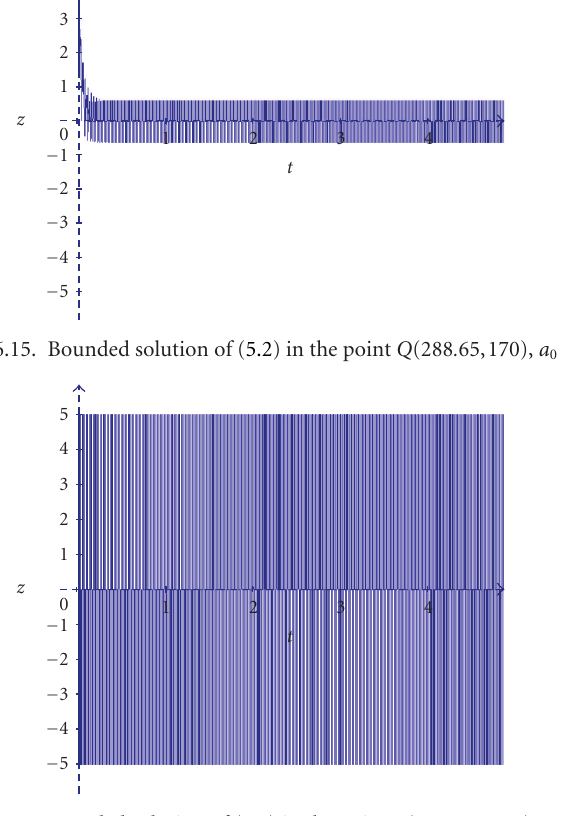
Figure 6.16 . Bounded solution of (5.2) in the point R (680,250 . 079), a 0 =